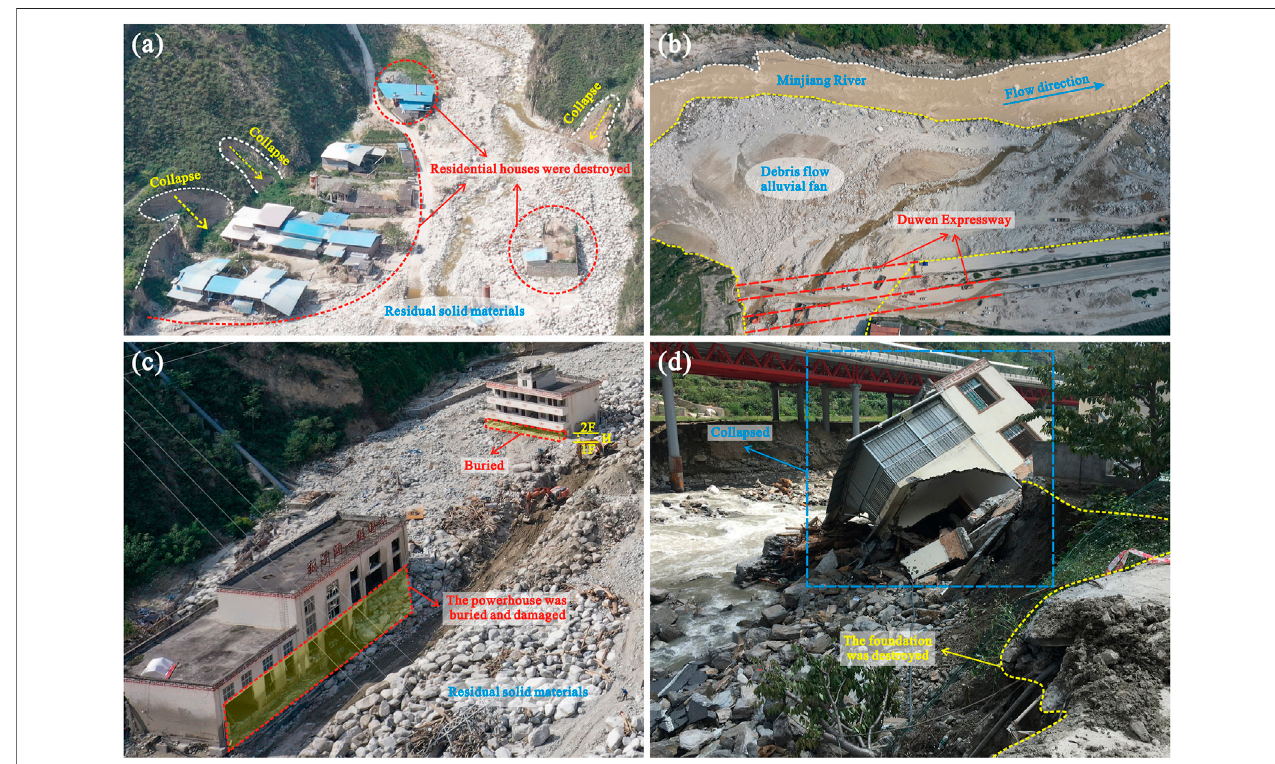
FIGURE3| Damagecausedbydebris fl owsinthe “ 8 · 20 ” event: (A) buriedhousesinBanziGully; (B) theblockedMinjiangRiveranddestroyedtraf fi cfacilitiesatthe mouth of the Dengji Gully; (C) damage to the Banzi Gully Grade I Hydropower Station; and (D) destroyed buildings along the Minjiang River.